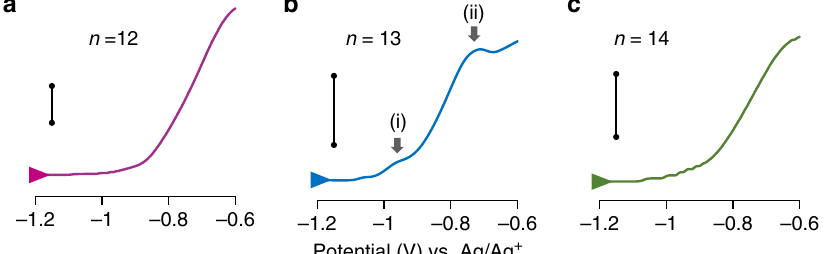
Fig. 4 Oxidation waves of the fabricated anionic aluminum cluster samples. They correspond to Al n clusters. a n = 12 (6 μ M), b n = 13 (4 μ M), and c n = 14 (4 μ M) in THF. The potential sweep was started from − 1.7 or − 1.8 V (open circuit potentials) at the scan speed of 0.025 V/s. Black bars indicate 10 μ A in a and c , and 5 μ A in b . NaPF 6 was used as an electrolyte (0.05